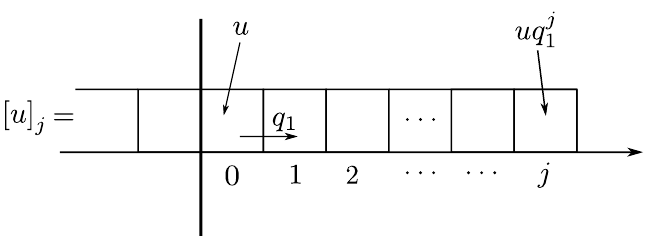
Figure 4. Interpretation of vector representation basis as a 1d-sequence of boxes. We call it the 1d Young diagram. [ u ] has j + 1 boxes right to the border. We note the boxes are labeled with j numbers starting from 0 , 1 , at the right of the border and extended left to the